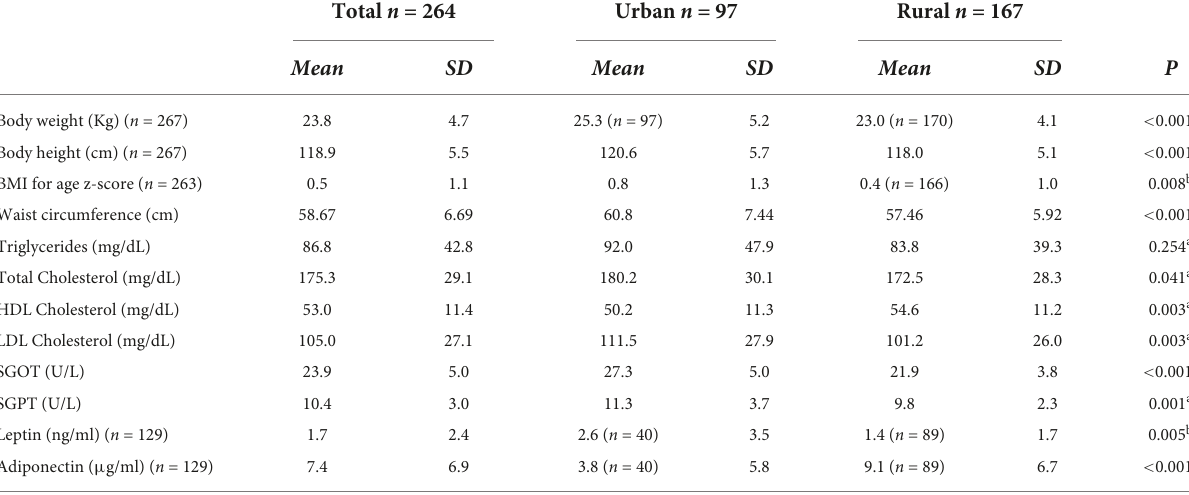
TABLE 2 Blood lipid, hepatic profile and weight status of the study participants. Total n = 264 Urban n = 97 Rural n = 167 Mean SD Mean SD Mean